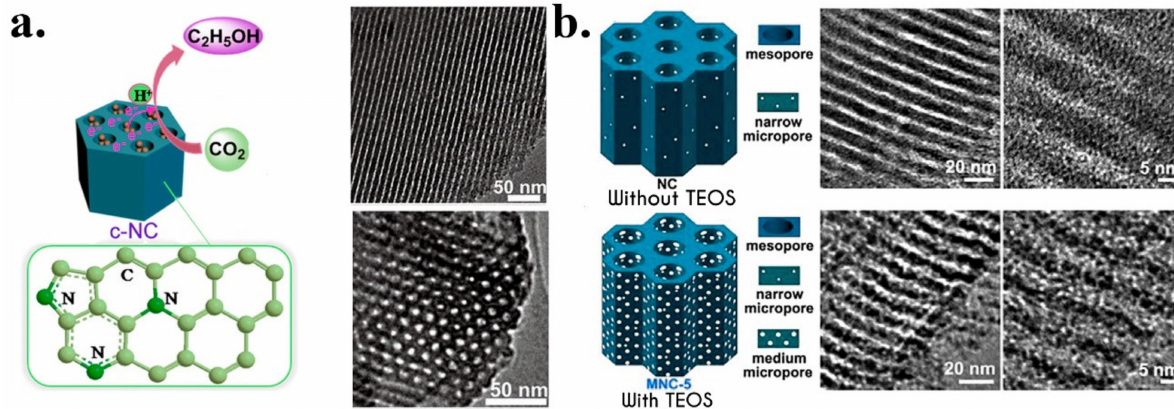
Figure 8. Pore structure illustrations and TEM images of ( a ) ordered mesoporous N-doped carbon adapted from [46] and ( b ) micropore-embedded ordered mesoporous N-doped carbons adapted from